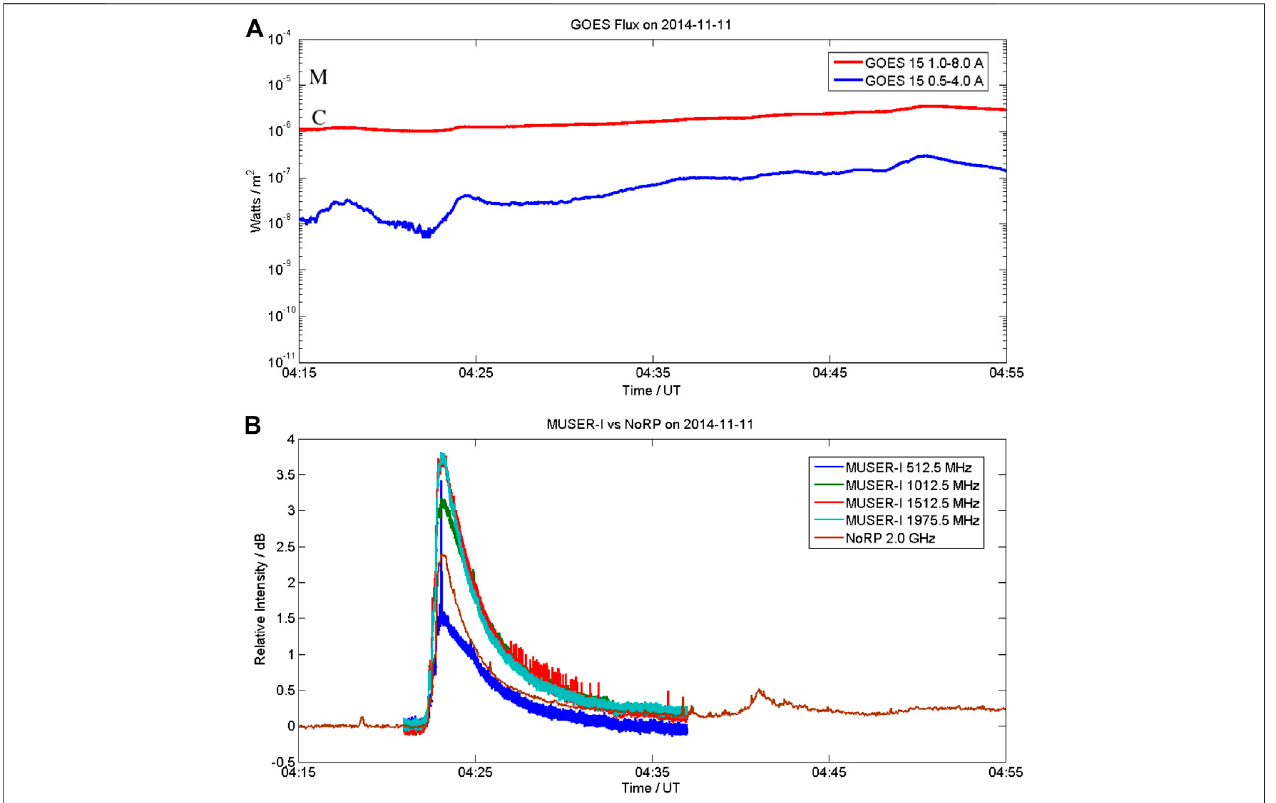
FIGURE 5 | (A) The temporal pro fi les of GOES SXR fl ux for the C3.4 class fl are starting from 04:22 UT and peaked at 04:49 UT on 11 November 2014. (B) The NoRP radio fl ux at 2 GHz(brown) and MUSER-I radio fl uxes at 0.5125, 1.0125, 1.5125 and 1.9755 GHz of the burst event peaked at 04:23 UT in a relative